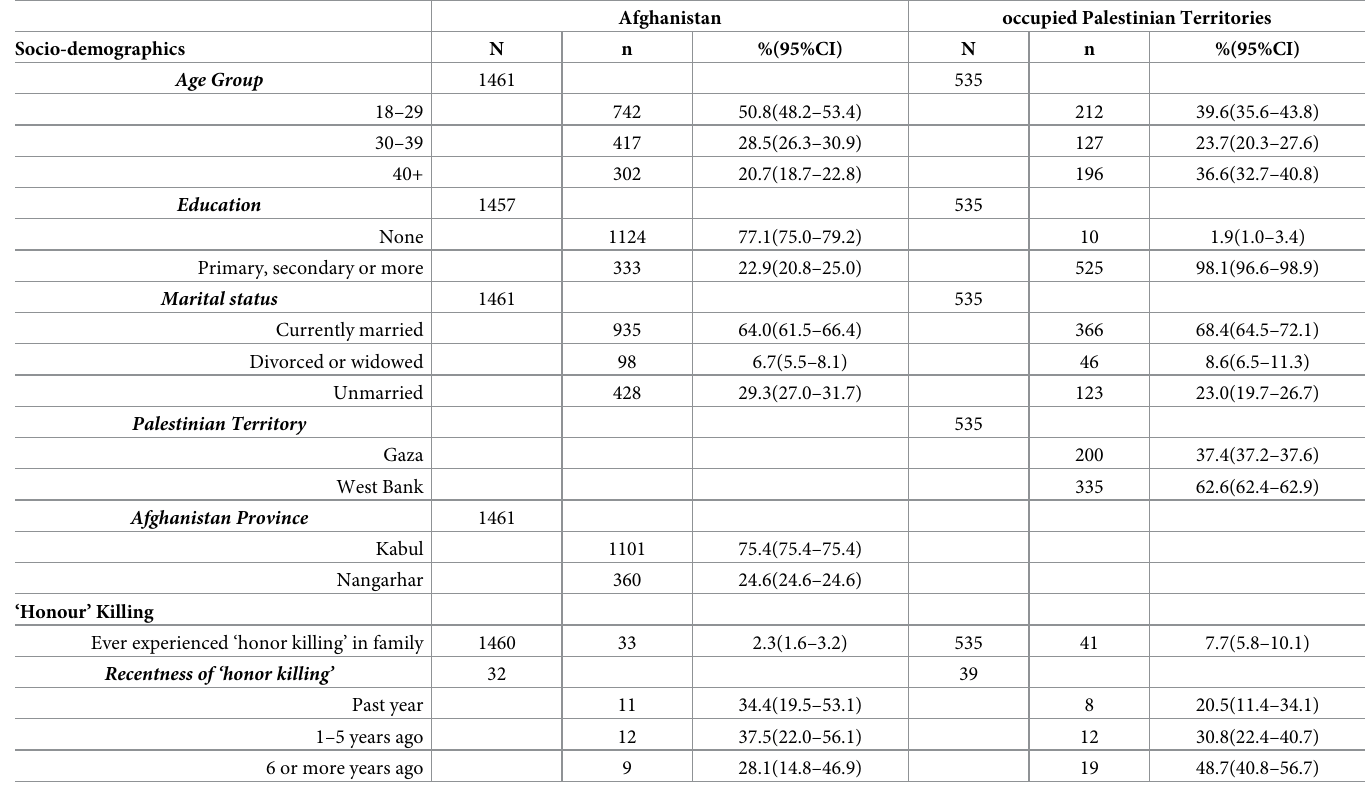
Table 1. Descriptive statistics for samples in Afghanistan and the occupied Palestinian